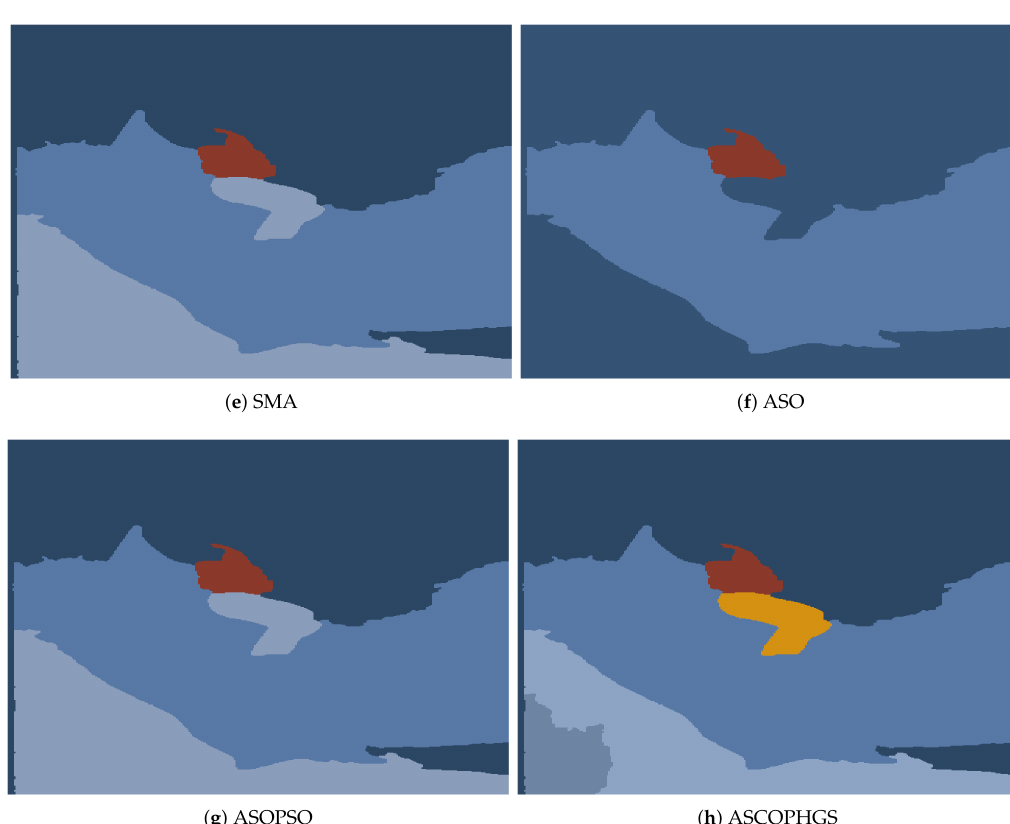
Figure 5. Segmentation of image I 4 BSDS 500 from BSDS500 datasets using the competitive algorithms.